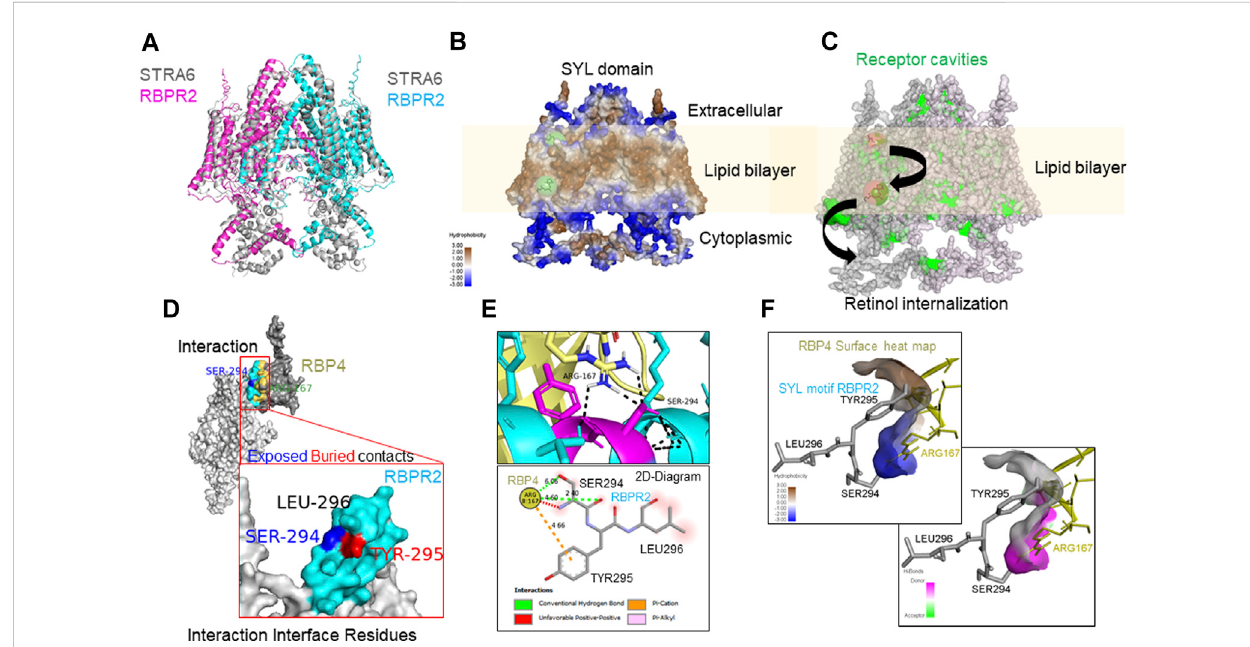
FIGURE 2 MoleculardockinganalysisofRBPR2-RBP4proteininteraction. (A) RBPR2structuralalignmentwithSTRA6dimer(pdb5SY1). (B) Heatmapindicating varying degrees of hydrophobicity within RBPR2, showing the lipid bilayer embedded regions in a RBPR2 dimer complex. The retinol binding prediction on RBPR2 dimer was performed by PyRX showing the possible regions of binding and internalization of retinol from extracellular matrix to cytosol, by utilizing the receptor cavities indicated in green on the right diagram (ref BIOVIA ® Discovery Studio Visualizer v21.1). (C) The docking of RBPR2 monomer (Light grey) and RBP4 (Dark grey) structure showing the interactions. The interaction interface residues are color-coded, Cyan for RBPR2 residues and Yellow for RBP4. To annotate the positional exposed and buried residues information the SER-294 blue and TYR-295 Red color coded. (D,E) The interaction of residues and 2D-Diagram showing the mode of interactions by Hydrogen bonds, Pi-Cation, Pi-Alkyl and solvent accessible surface in Red shade. (F) The surface heat map of hydrophobicity and hydrogen bond of RBP4 surface showing the SYL motif of RBPR2 interacting in the pocket, analyzed by BIOVIA ® Discovery Studio Visualizer